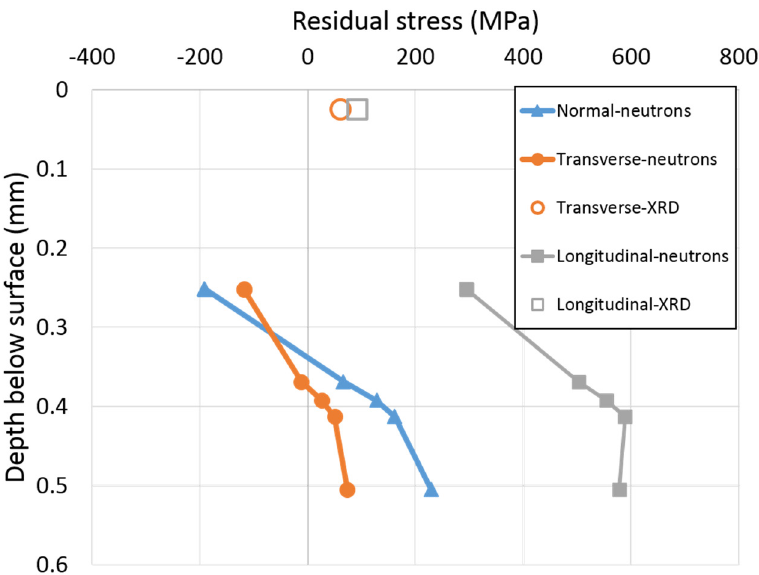
Figure 10. Near surface residual stress obtained 2 mm away from the weld toe (SS-HAZ) using X-ray and neutron diffraction.